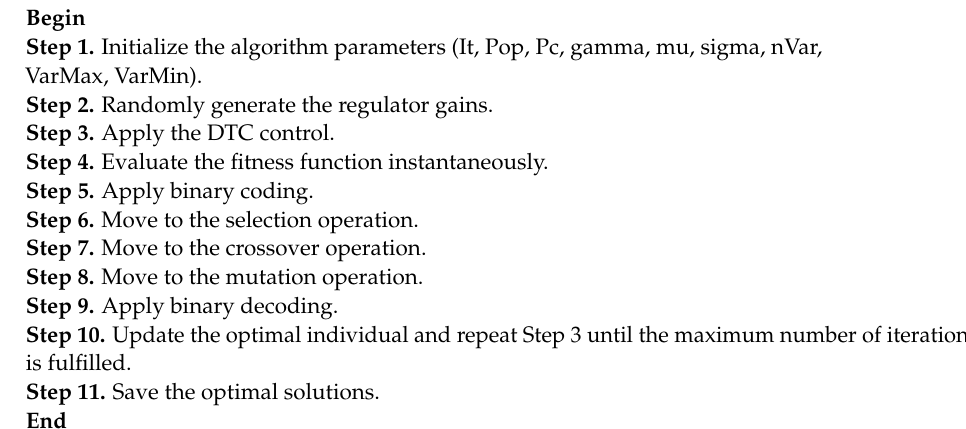
Algorithm 1. Genetic